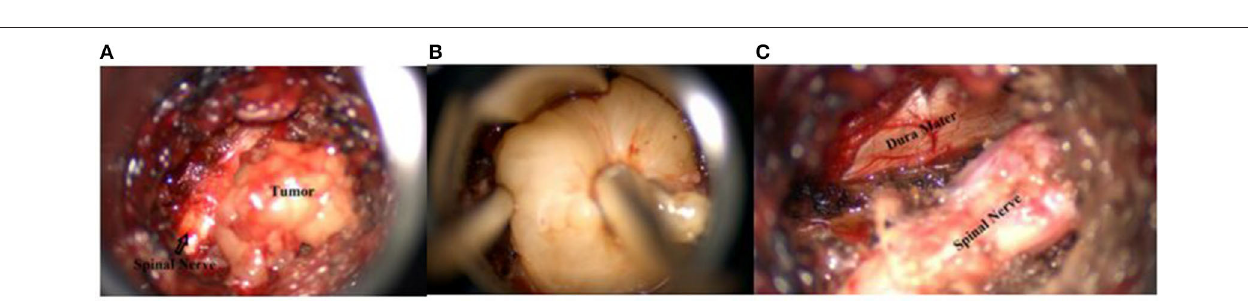
the average 3 days after the surgical procedure, and 3.9 points (from 2 to 0 points) 3 months after the surgery. Enhancement was also observed in ODI [35.40% (50–20%) on average] in 3 days, and reduced to 24.20% (16–32%) on the average 3 months after the operation. The results of the performed surgery in control group are shown in Table 2